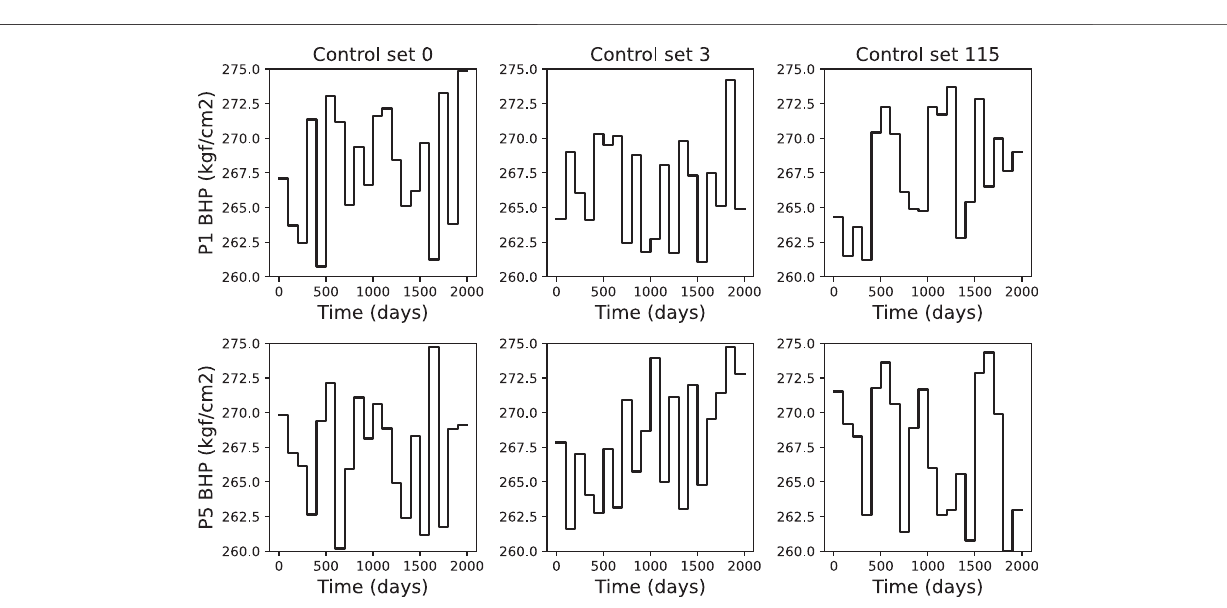
Frontiers in Applied Mathematics and Statistics |